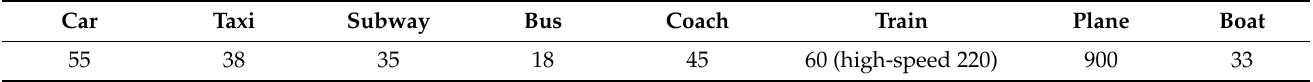
Table A5. Modal speed